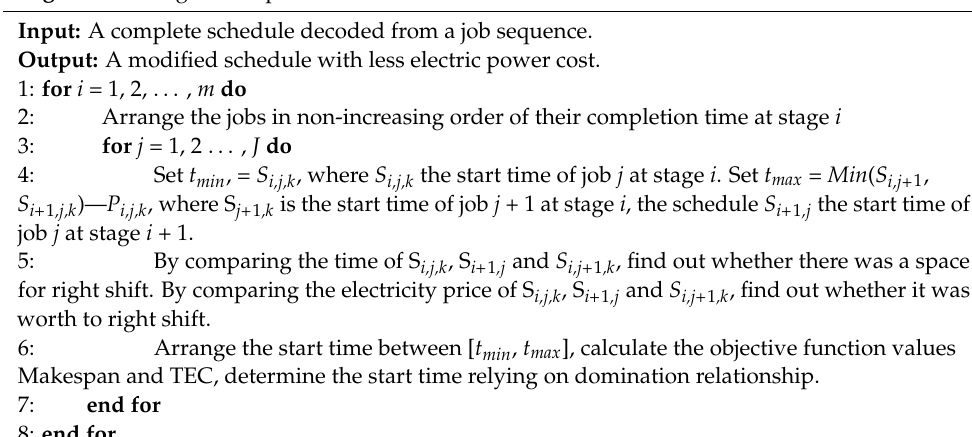
Algorithm 1. Right-shift